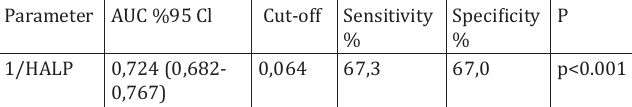
Table 2 ROC curve for estimate mortality in Covid-19.